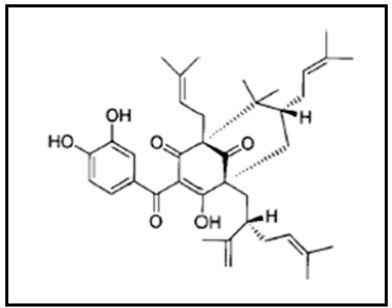
Figure 1. Structure of garcinol.